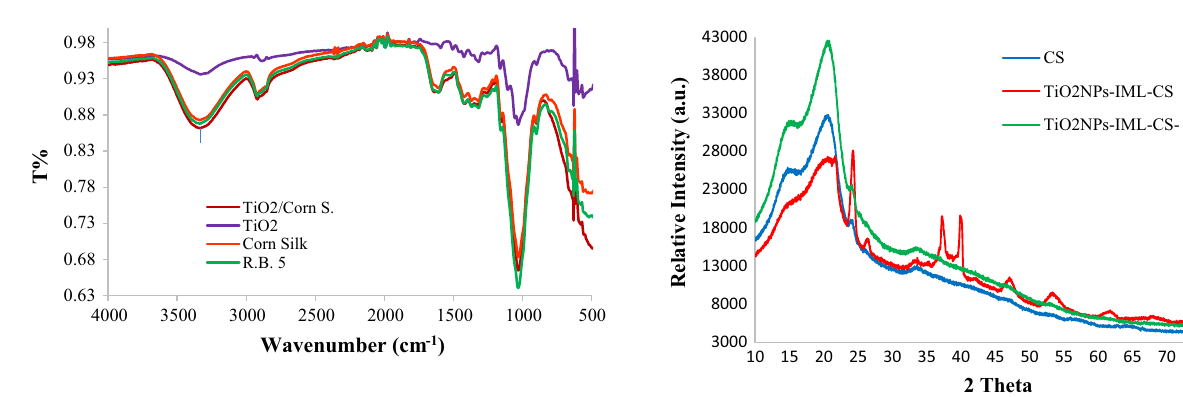
Fig. 4 XRD pattern of CS, TiO